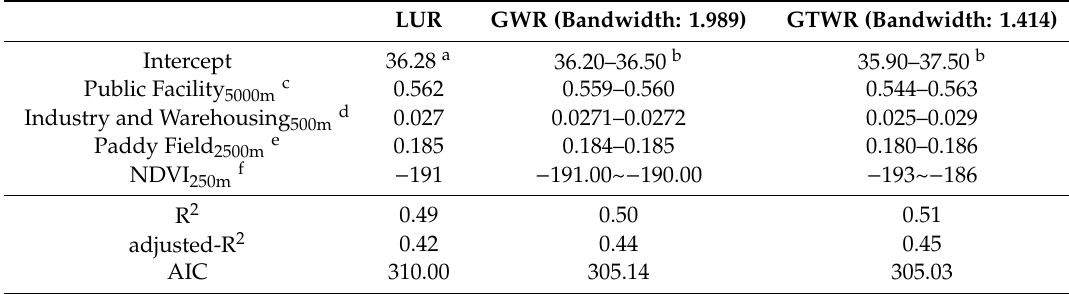
Table 2. Comparison of Final Model for PM 10 using LUR, geographically weighted regression (GWR) and geographic and temporal weighted regression (GTWR).